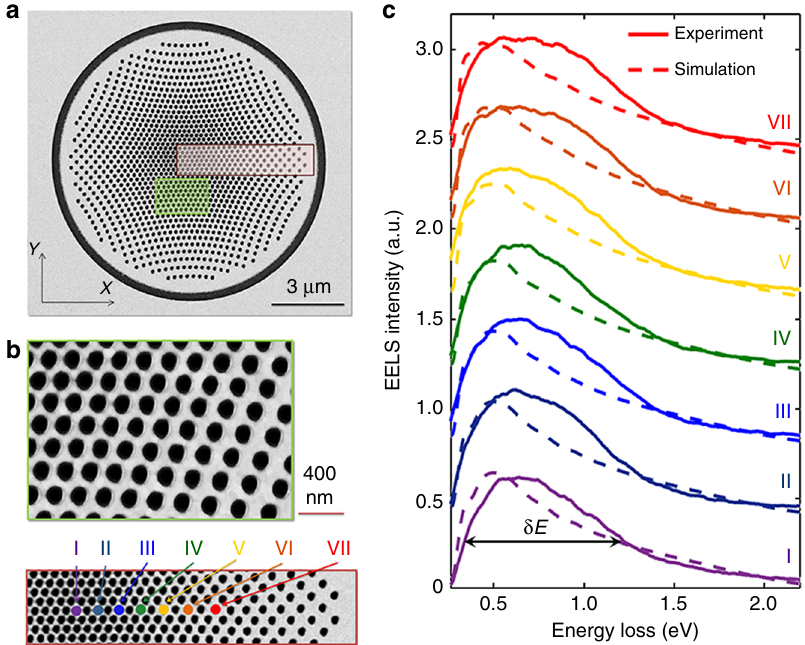
Fig. 2 Characterization of the fabricated planar lens. a Dark fi eld STEM image of the fabricated lens. b The same image at higher magni fi cation from the green and red boxes in a . c Experimental and simulated EELS spectra (200 keV primary electron beam energy) at the positions depicted by colored spots indicated in